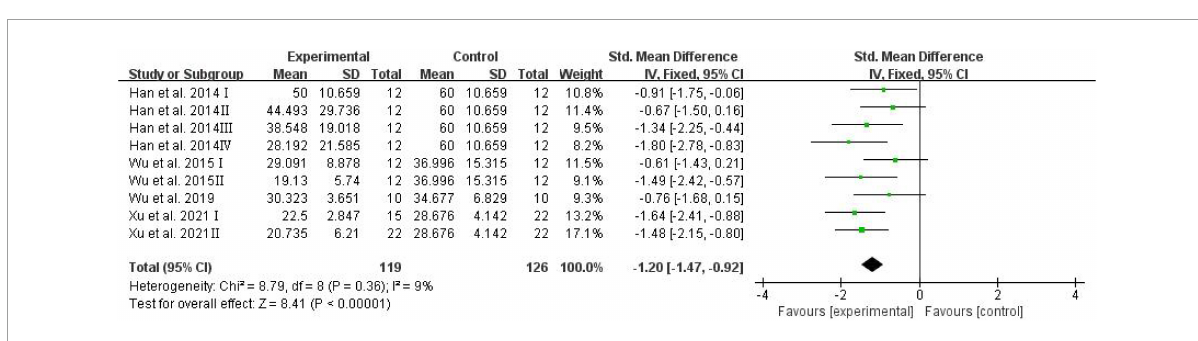
FIGURE3 Forest plot of the percentage of distance in target quadrant in the Morris water maze